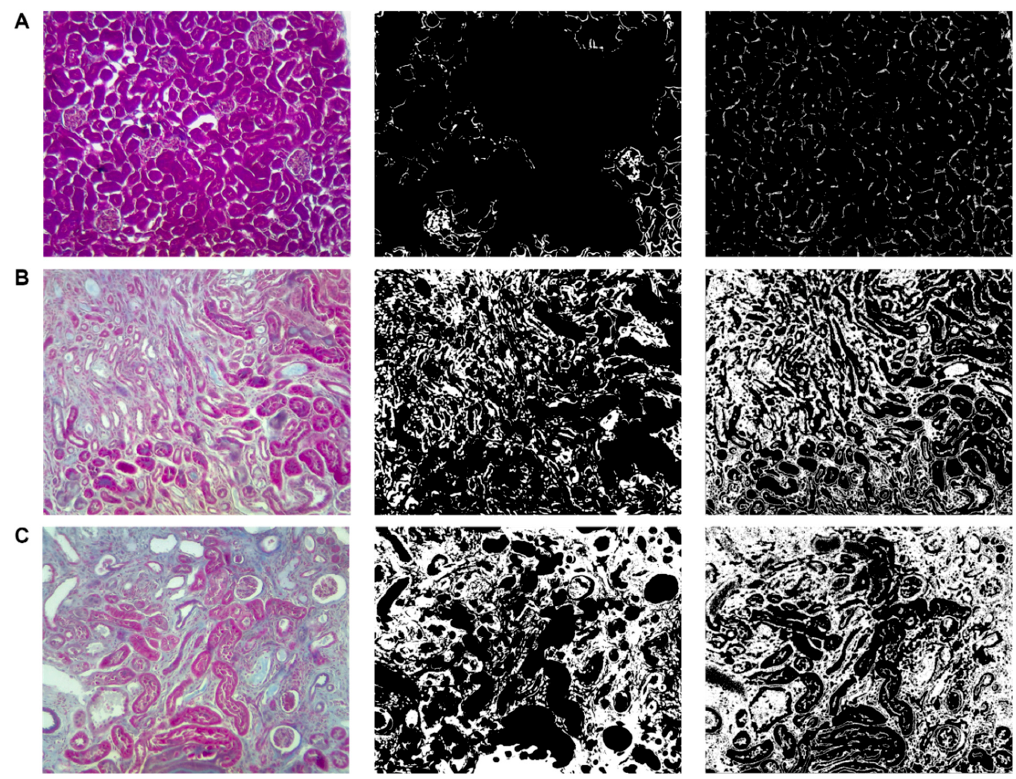
Figure 10. Fibrotic area measurement of kidney samples. From left to right: original image, CellPro- filer™ pipeline result, ImageJ result. ( A ) Treated with vehicle, ( B ) treated with adenine (50 mg/kg), and ( C ) treated with adenine (100 mg/kg). Magnification of 200×. No significant statistical differences were found between the fibrosis percentage in the measured samples using both CellProfiler™ and ImageJ programs (Figure 11).